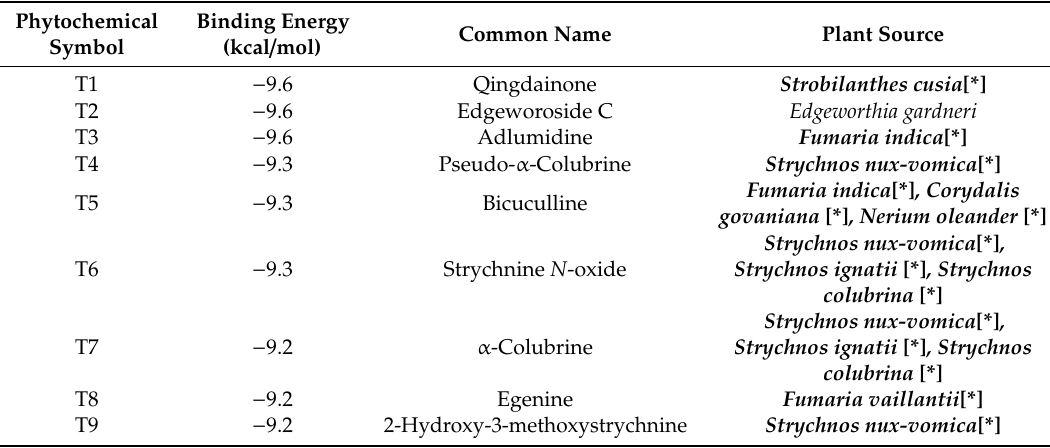
Table 1. Herbal sources of top 9 phytochemical inhibitors of TMPRSS2. For each phytochemical, the table gives the symbol, docked binding energy, common name and plant source. Plant sources which have been reported to have antiviral or anti-inflammatory use in traditional medicine literature are shown in bold and marked with an [*]